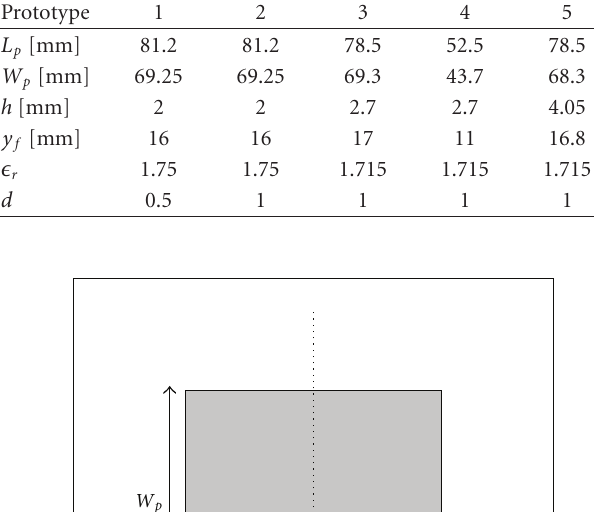
Table 2: Proportionality factors η for the compression correction term.